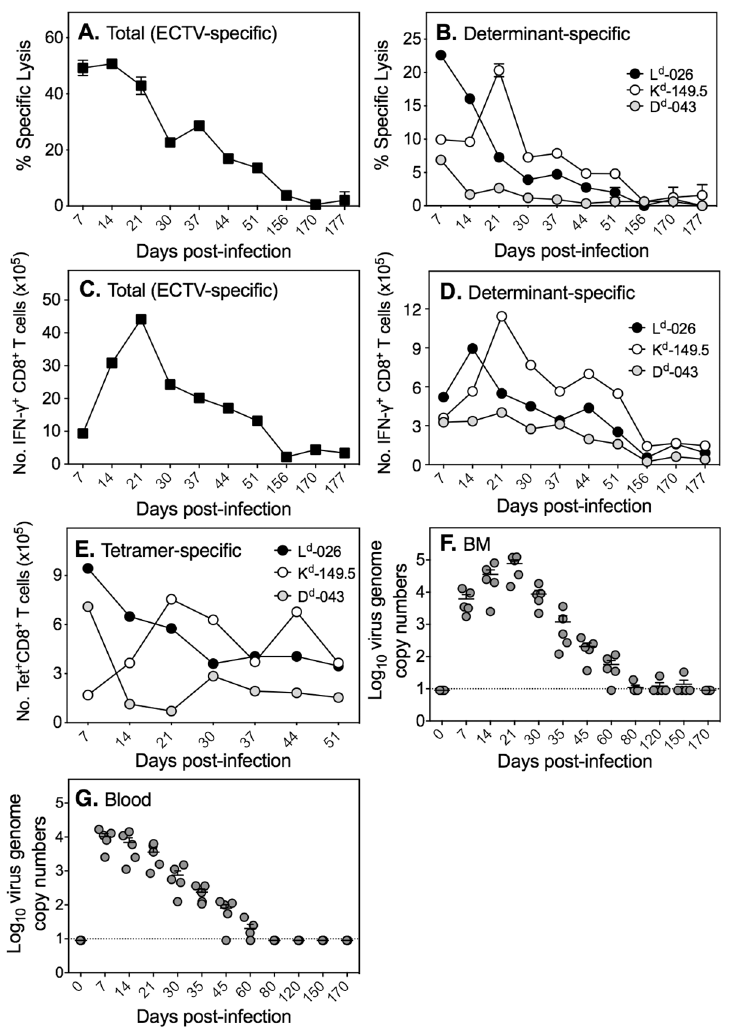
with 500 PFU ECTV-IFN- γ bp Δ and functional and phenotypic assays done on days 7 till day 177. (A) Percent specific lysis of ECTV-infected, 51 Cr-labelled P815 targets by splenocytes from infected mice at 100:1 effector: target ratio. (B) Percent specific lysis of ECTV peptide determinant-pulsed, 51 Cr-labelled P815 targets by splenocytes from infected mice at 100:1 effector: target ratio. (C) Kinetics of ECTV-specific (total) IFN- γ + CD8 T cells numbers. (D) Kinetics of ECTV peptide determinant-specific IFN- γ + CD8 T cell numbers. (E) Kinetics of peptide-MHC class I tetramer + CD8 T cell numbers. (F) Kinetics of ECTV genome copy numbers in BM. (G) Kinetics of ECTV genome copy numbers in blood. The limit of virus genome detection is 10 copies, shown by the dotted line. Data shown in panels F and G are from the same experiment in which 5 mice infected with 500 PFU ECTV-IFN- γ bp Δ were sacrificed on the indicated days but qRT-PCR assay run on the same